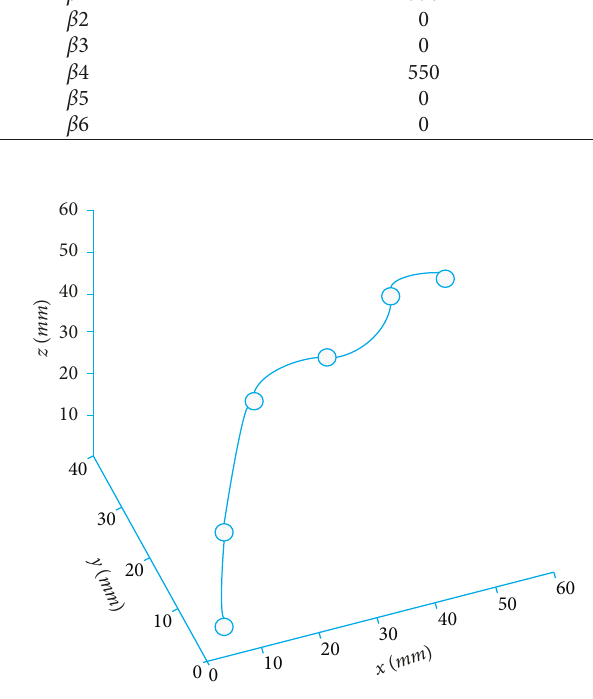
Figure 3: Trajectory simulation of manipulator.